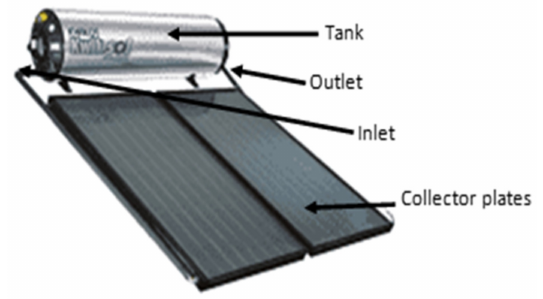
Figure 1. A flat plate collector SWH.